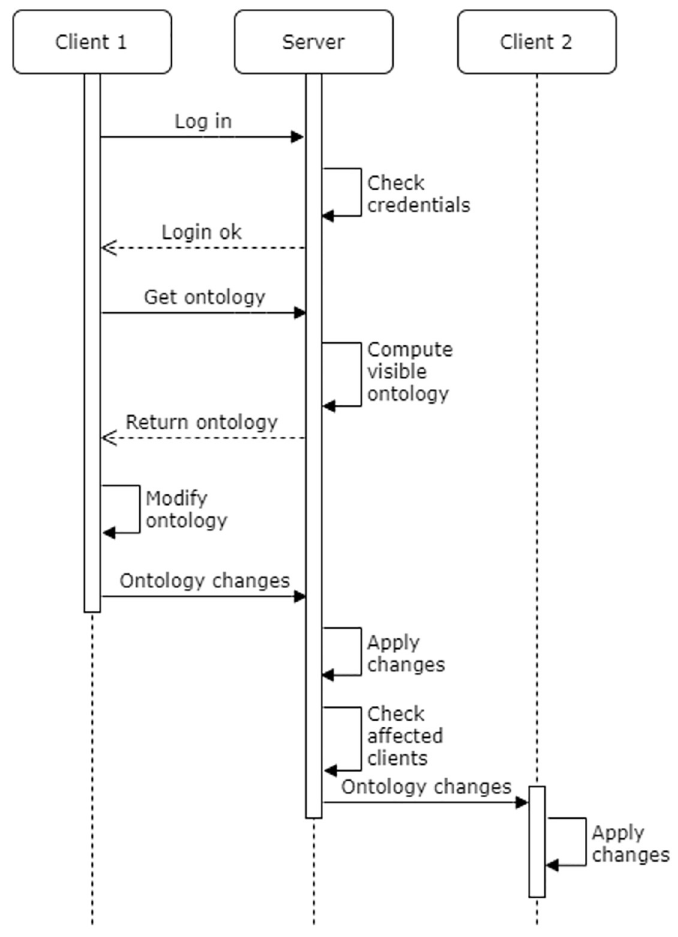
Fig 3. Ontology management. A sequence diagram depicting how the collaboration platform manages the underlying ontology. The server and the clients each hold a copy of the ontology; the server is responsible for ensuring that these remain synchronized as clients modify their local